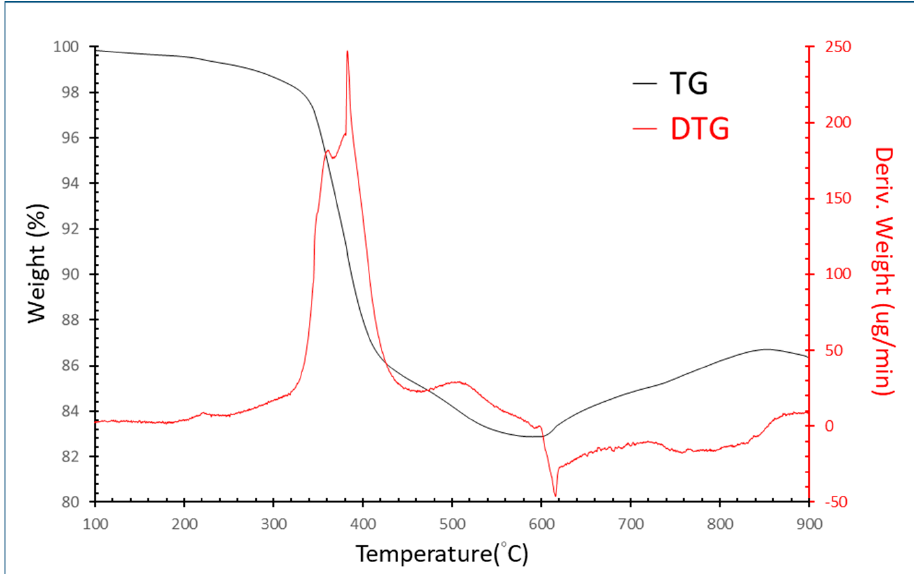
Figure 2. TG/DTG curves of EcSETCs with nitrogen gas (N 2 ).